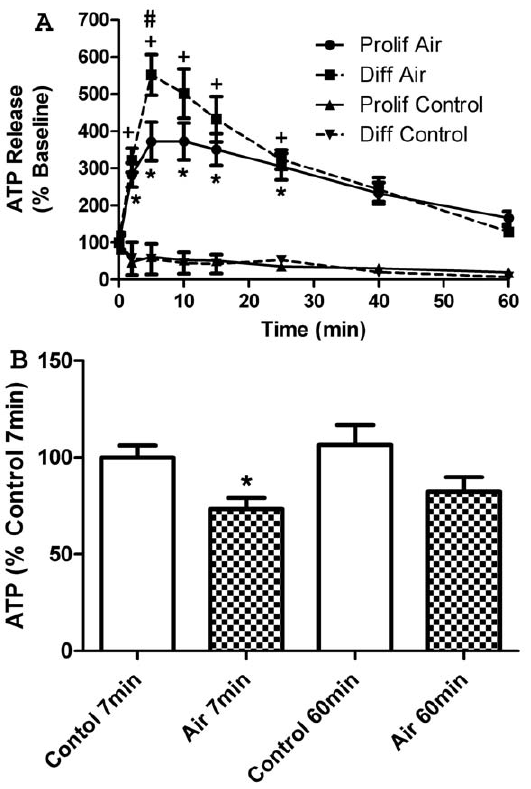
Figure 2. Time course and extent of intracellular ATP release. A. Time course of air-stimulated ATP release. Extracellular ATP levels were quantified following a 15 second air exposure (Air) or an exchange of half the media (Control) in proliferating (Prolif) and calcium differentiated (Diff) NHEK cultures. Air-stimulated ATP release was significantly higher in differentiated cultures at the five minute time point, but remained significantly elevated for 25 minutes in both cultures. Values represent the mean + / 2 SEM for 13 air-exposed and 2 control dishes per group shown as % baseline. * p , 0.05 vs. 0 minute Prolif, + p , 0.05 vs. 0 minute Diff, # p , 0.05 Diff vs. Prolif. B. Intracellular ATP following air exposure. To determine the extent of intracellular ATP reduction after air exposure, levels of ATP in cell lysates of air-exposed and control confluent NHEK cultures were measured. Air-exposed cultures showed a significant reduction in intracellular ATP at the time of peak ATP release (7 minutes after exposure). This reduction was no longer significant by 60 minutes after air exposure. Values represent averages + / 2 SEM of 6 dishes per group, * p , 0.05 vs. control 7